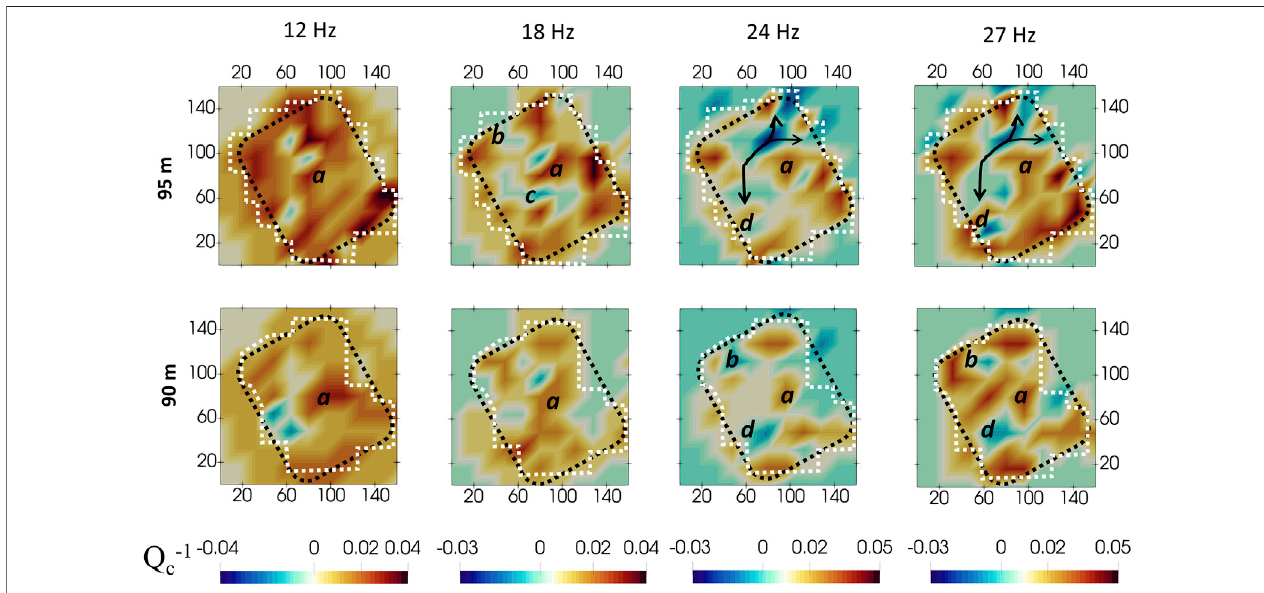
FIGURE 7 | Coda attenuation variations at different frequencies. The white and black dashed polygon represents the resolved and survey area ( Figure 1 ), respectively. We scaled the colour legend to the maximum and minimum for each frequency. The labels are described in the main text.